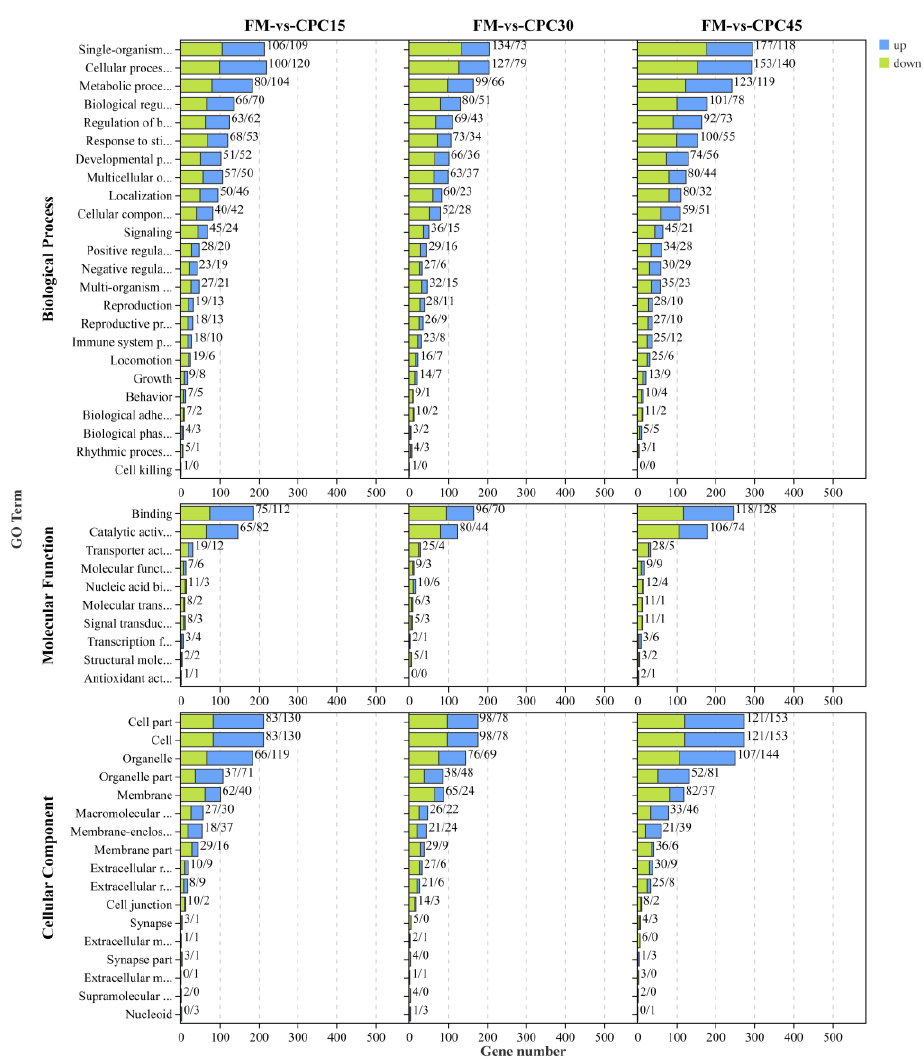
Figure 4. GO enrichment analysis of DEGs containing CPC-fed L. vannamei and FM groups. Three main GO categories: cellular components, molecular functions, and biological processes. x -axis indicates the number of DEGs, and y -axis indicates GO categories and subcategories.